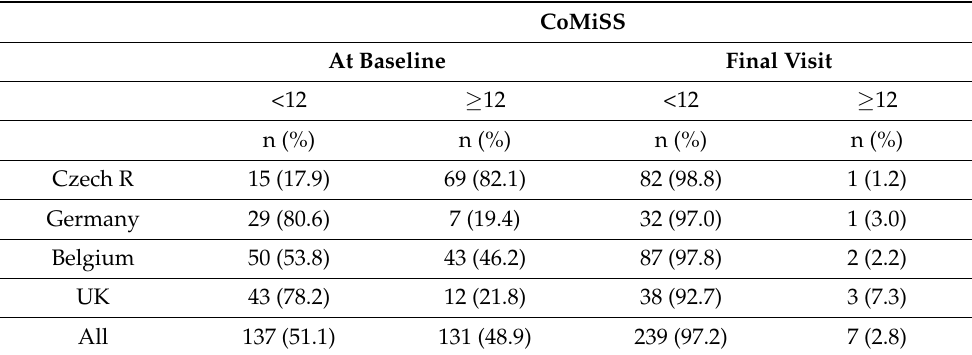
Table 7. CoMiSS < and >12 distribution per country at baseline and final visit.